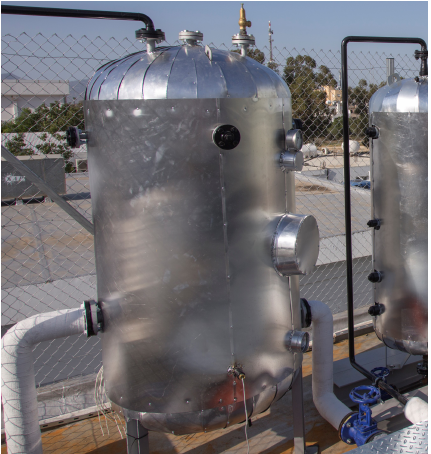
Figure 4. Buffer tank of oil with electric heaters wrapped around, allowing the expansion of the oil under pressure with Nitrogen